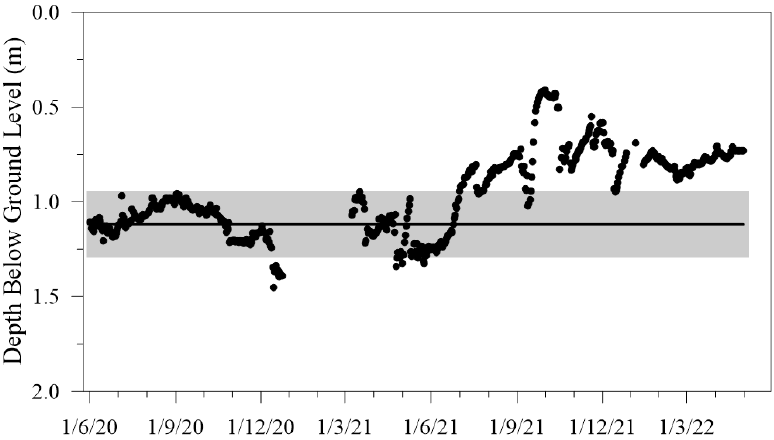
Figure 8. Depth of the condensation level under the VSCS monitoring station, retrieved from the recorded ground temperature profile. The background level (gray area) was calculated from the hourly record during a period of background degassing (June 2018–June 2019, average value, and standard deviation [53]).